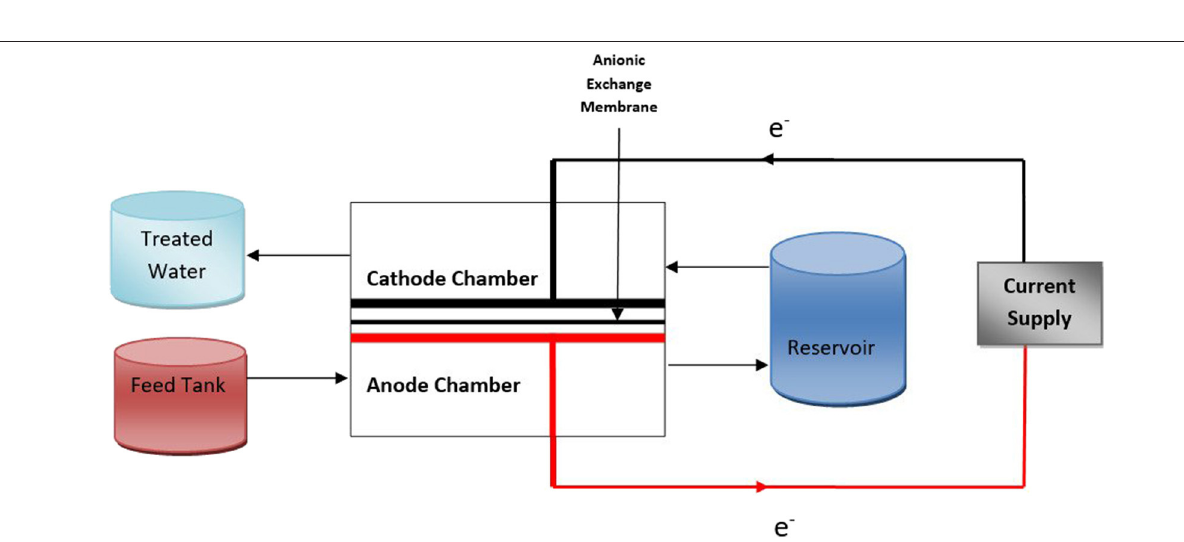
Frontiers in Energy Research |